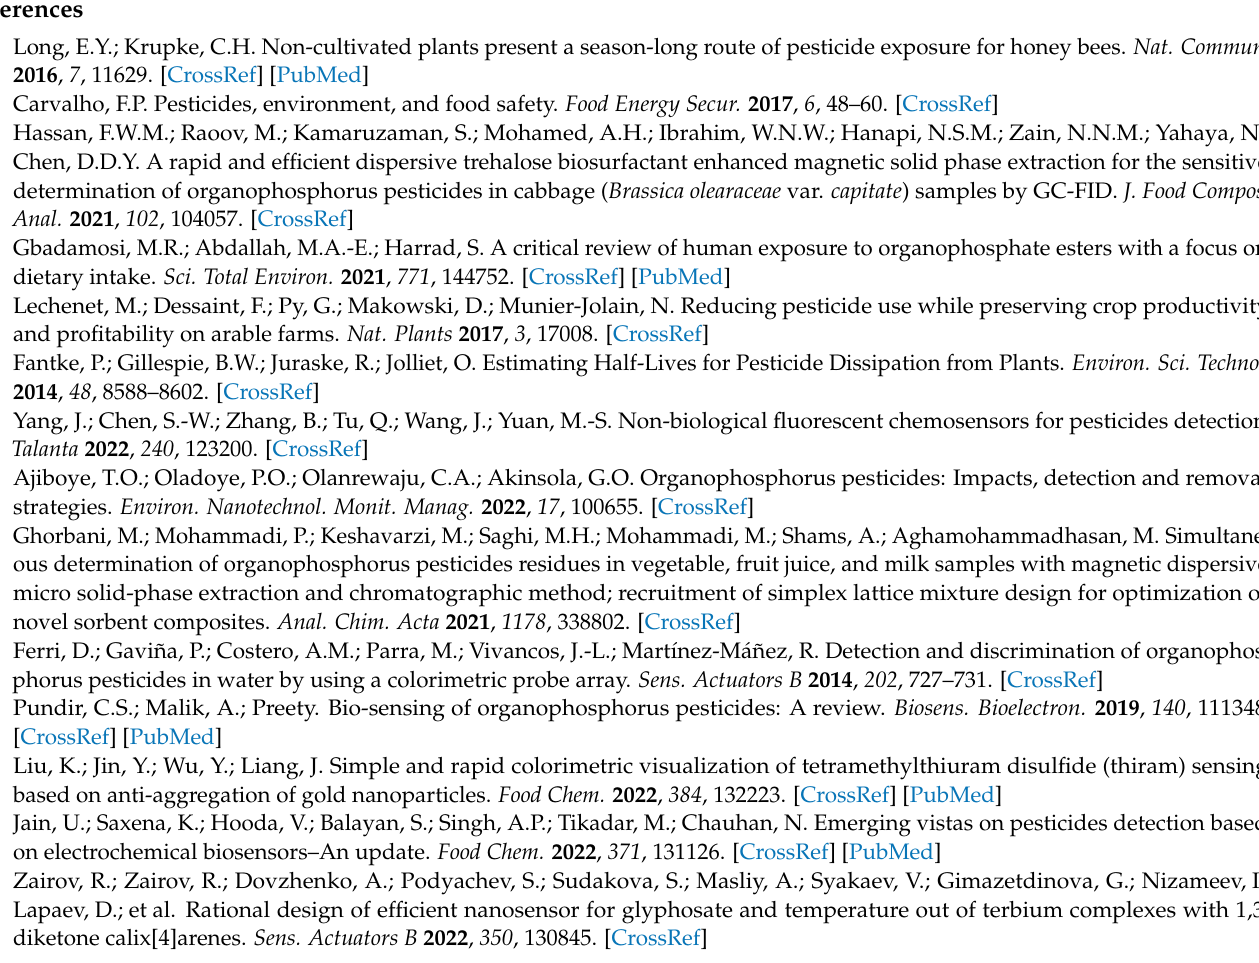
Table S2: Concentrations of the interference